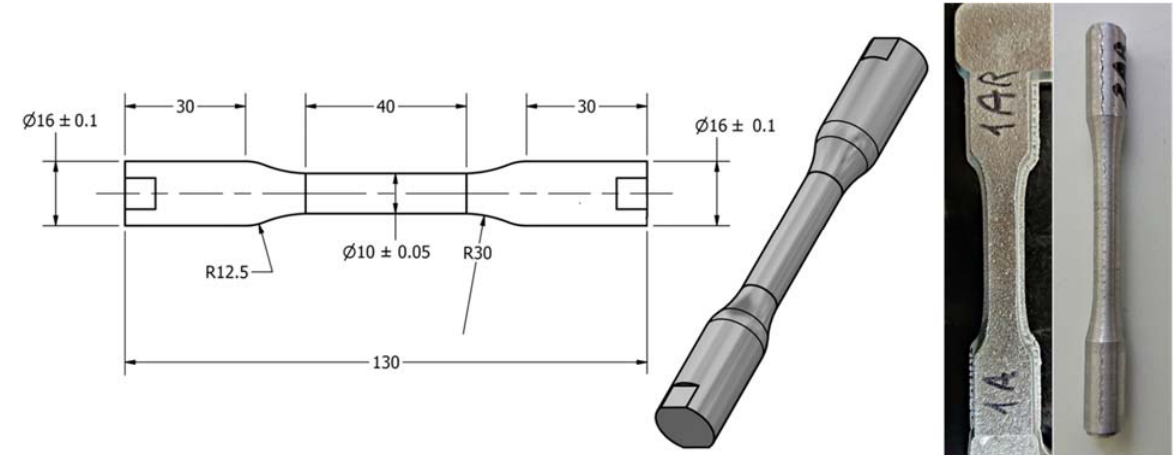
Figure 3: Geometry of tensile specimens (mm) and picture of a sample before and after machining.